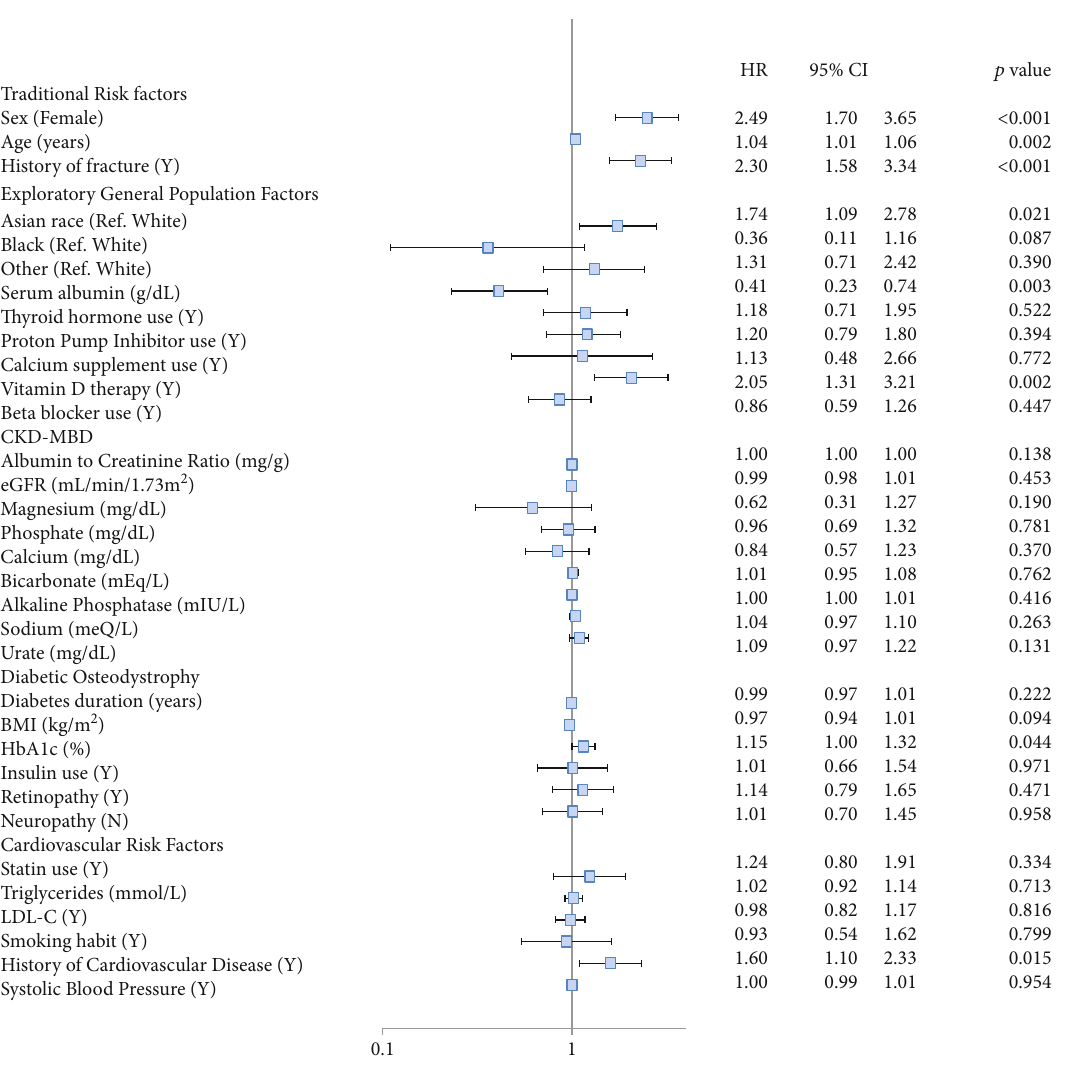
Figure 1: Multivariable Cox-proportional model for all variables and fracture. CKD-MBD: chronic kidney disease-mineral bone disorder; CI: con fi dence interval; eGFR: estimated glomerular fi ltration rate (note: estimated glomerular fi ltration was calculated using the CKD-EPI (CKD Epidemiology Collaboration) formula); HR: hazard ratio; LDL-C: low-density